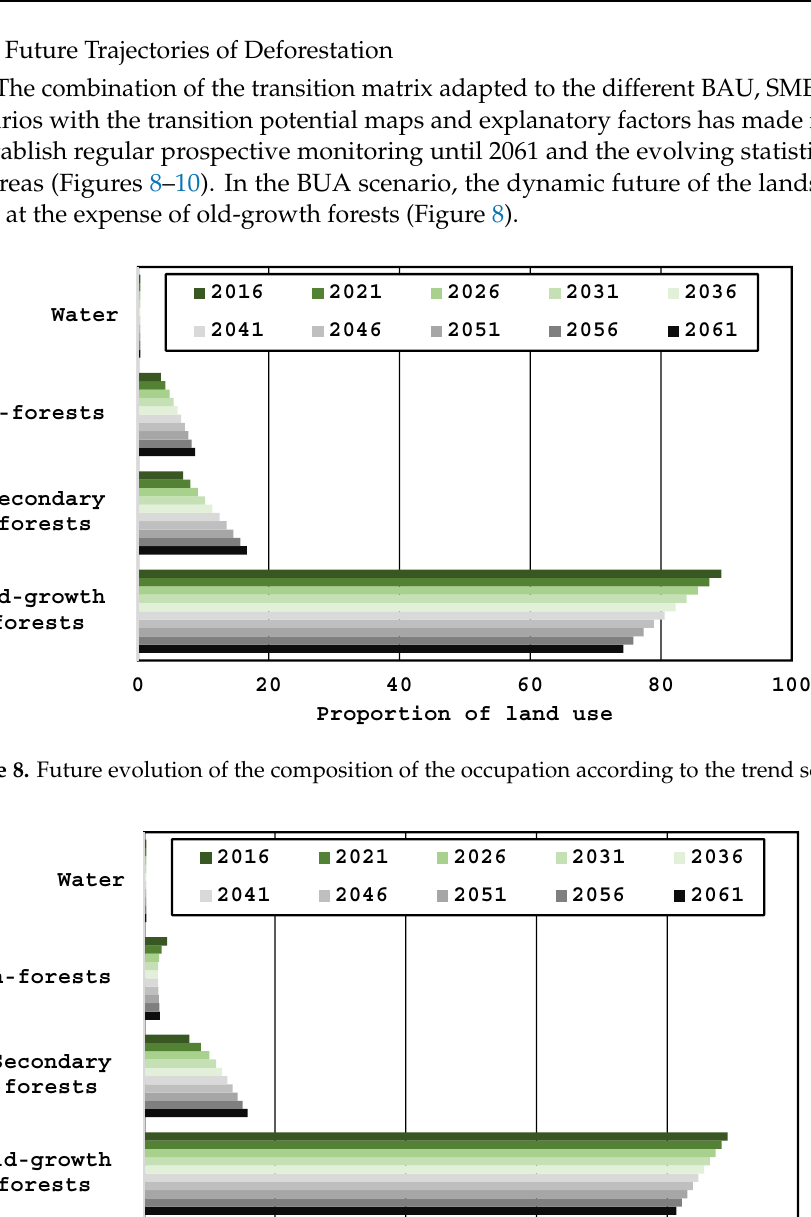
Figure 10. Future evolution of the composition of the occupation according to the REG scenario. Between 2016 and 2061, 28.84% of the proportion of the landscape occupied by old- growth forests will be converted to secondary forests (12.62%) and non-forests (17.52%). The non-forest class will experience a dramatic increase in the years to come. It represents 3.51% of the proportion of the landscape in 2016. It will cover more than 25.25% of the landscape by 2061. The proportion of the landscape that will remain unchanged is esti- mated at 64.22% of the total area landscape (respectively, 59.13% covered by old-growth forests, 1.92% by secondary forests, 2.86% non-forest and 0.31% water). Table 9 shows the transitions obtained in the REG scenario between 2016 and 2061.